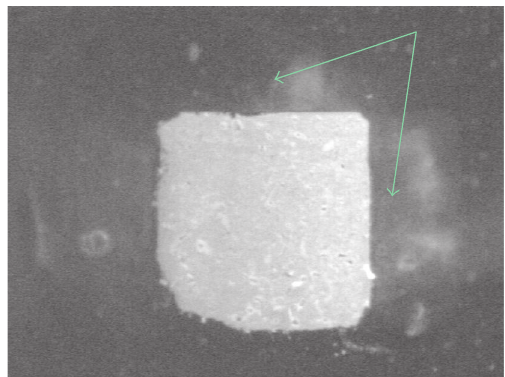
Figure 4: Collagen/PVP film surface after laser treatment ( F = 0 . 4 J/cm 2 , 30 pulses). Green arrows indicate a material deposition; black area represents nonirradiated region of the collagen/PVP film. In the middle of the irradiated spot, the surface rupture is seen.